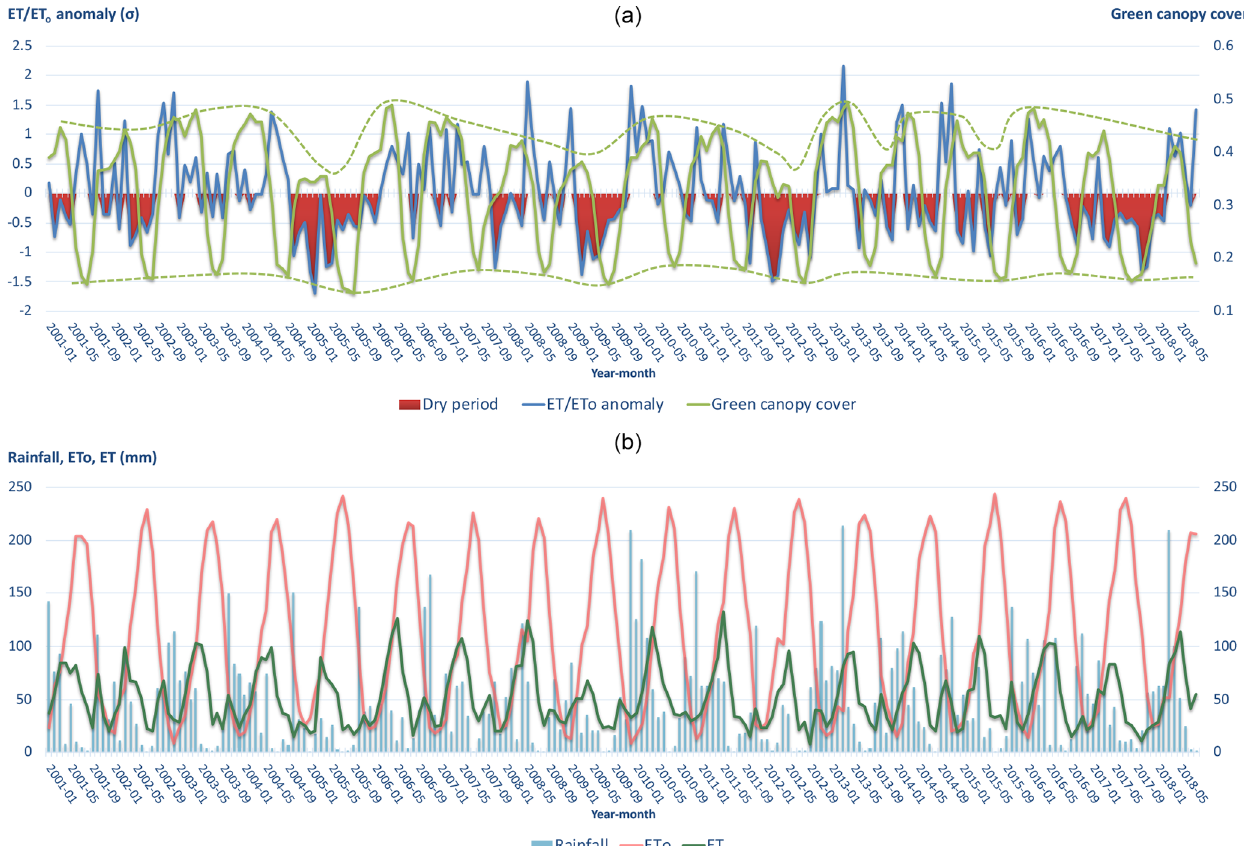
Figure 7. (a) Monthly evolution of evapotranspiration anomalies (blue line) of the oak savanna area of the Iberian Peninsula from January 2001 to August 2018, with negative values indicating drier than normal conditions (depicted in red) and green canopy cover (green line). The dashed green lines connect the annual maximum and minimum values of f c . (b) Monthly evolution of rainfall, ET o and ET in the same region and time